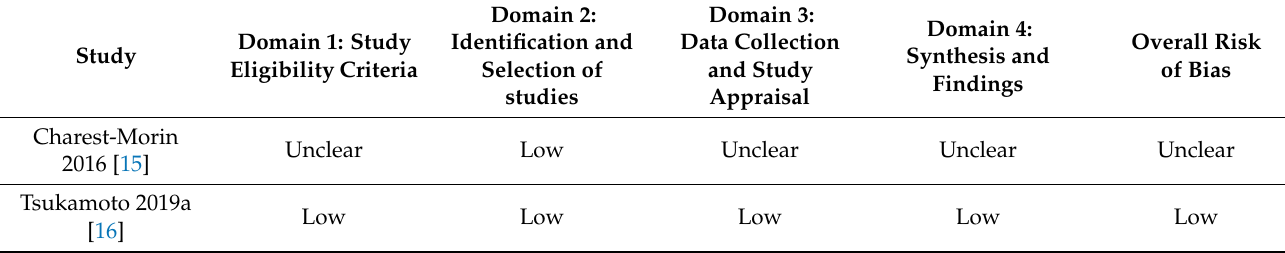
Table 1. Risk of Bias in Systematic Reviews (ROBIS) evaluation of included systematic